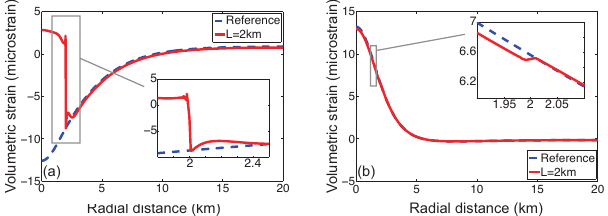
Figure C1. Volumetric strain after 1000days along profiles through the aquifers for the reference case in comparison to an aquifer with a central impermeable portion out to a radial distance of 2km. (a) pyroclastic aquifer, (b) lava flow